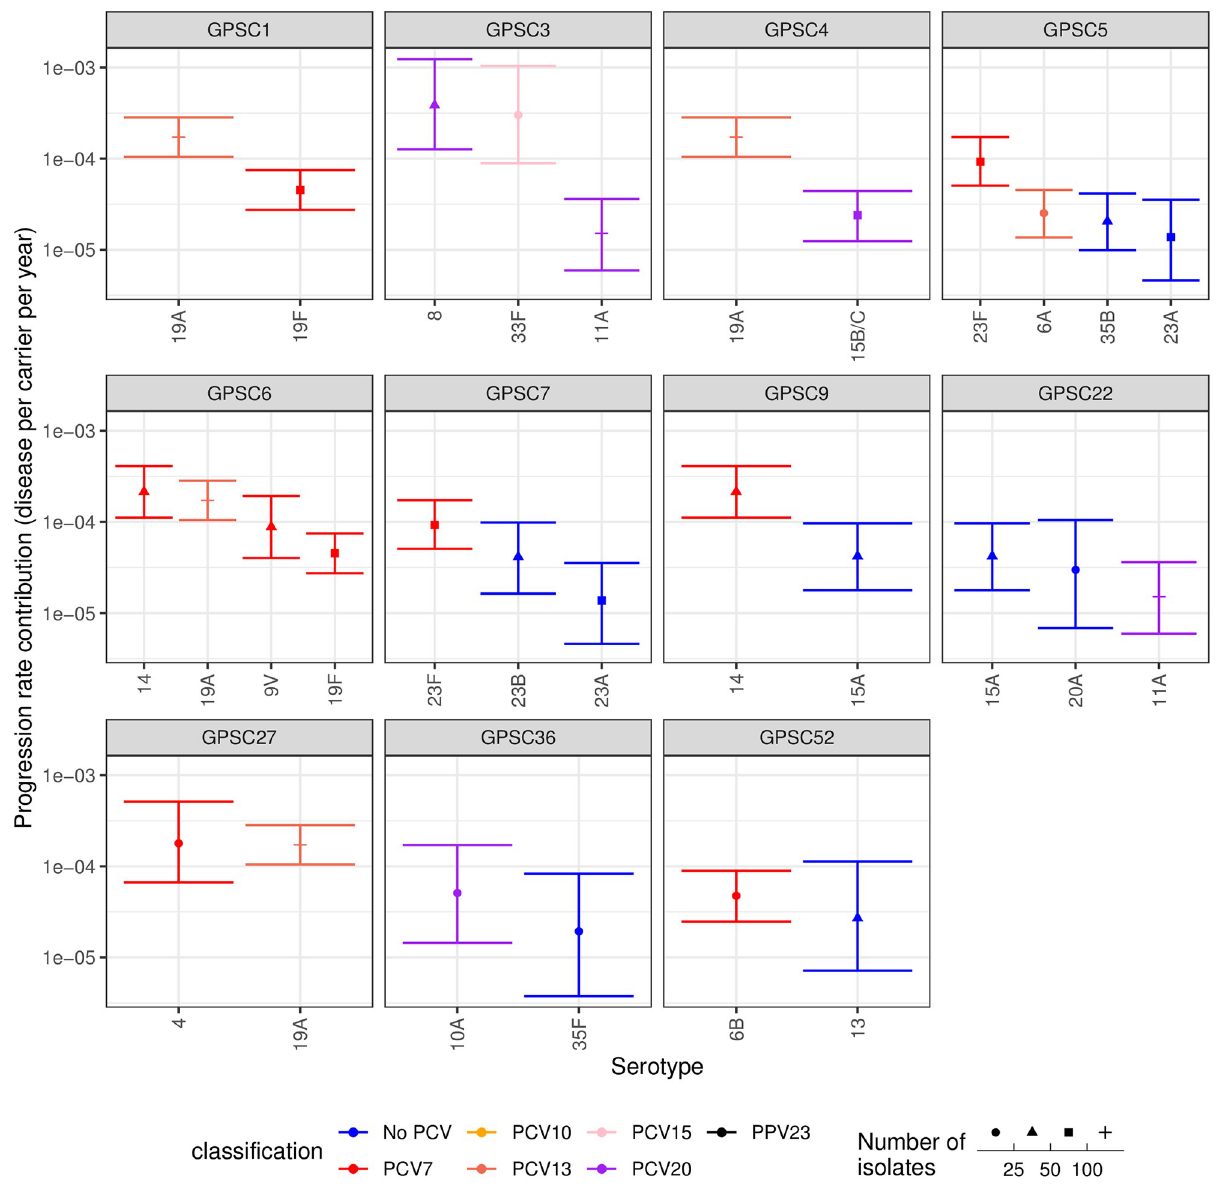
Fig 5. Estimates of the invasiveness associated with serotypes inferred from genotyped isolates using the study-adjusted type-determined strain- modified model. Serotypes are arranged by the strains in which they are found. Data are only shown for strains found in multiple serotype-strain combinations, each represented by at least ten isolates across the studies with genotype information. Points represent the median estimate, and are coloured by the vaccine formulations in which the corresponding serotype is present. The error bars represent the 95% credible intervals. The shape of the point represents the sample size on which the estimate is